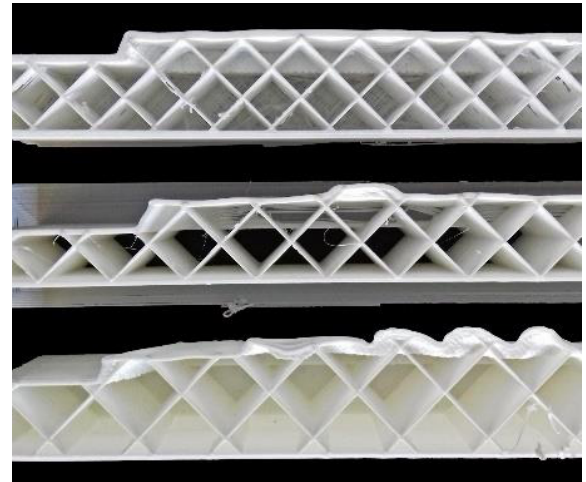
Figure 15. 3D print of the pothole model.